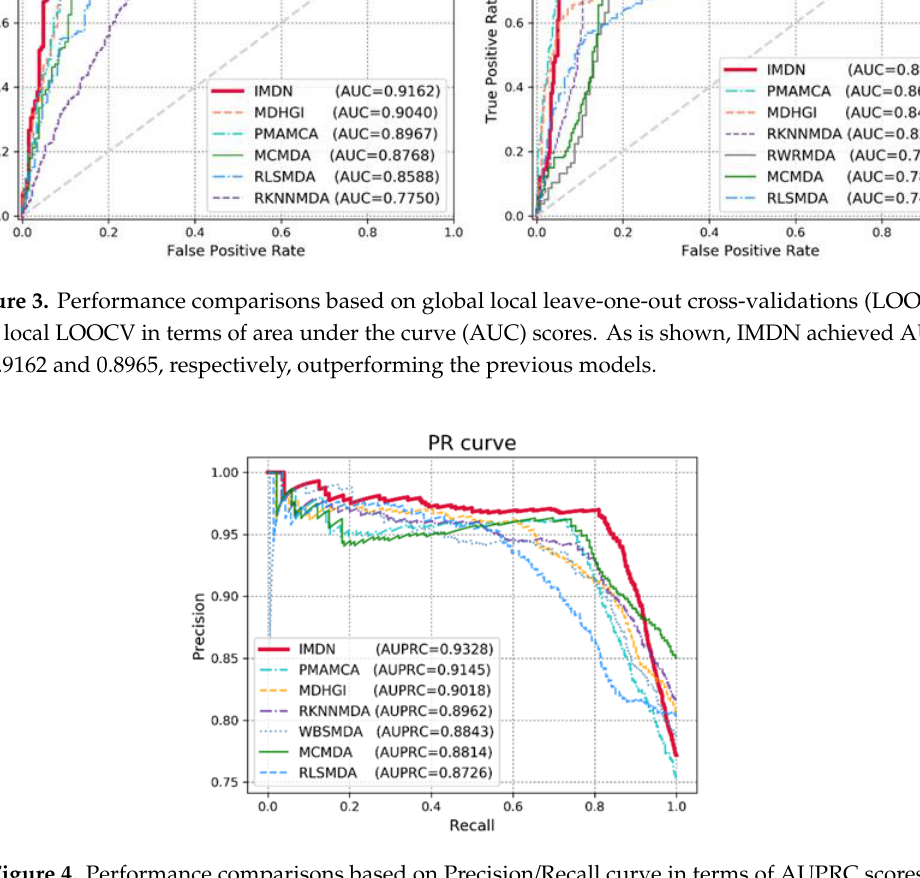
Figure 4. Performance comparisons based on Precision/Recall curve in terms of AUPRC scores.